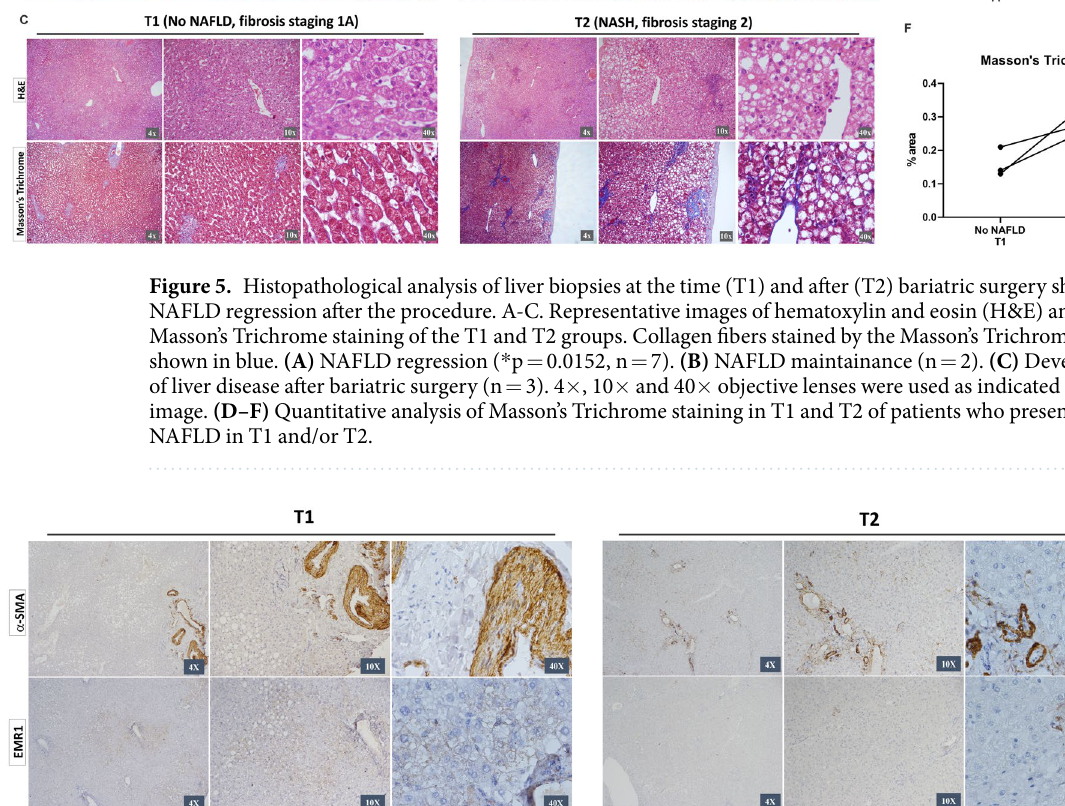
affection worldwide in the recent decades. On the other hand, liver disease associated with obesity and the conse- quent evolution to steatosis, steatohepatitis, cirrhosis and hepatocellular carcinoma has become one of the main causes of liver failure and transplantation in recent years, with the aggravating possibility of recurrence in the transplanted organ 36,37 . In our cross-sectional retrospective study, the NAFLD incidence evaluated by histological examination was 46.48% among the morbidly obese patients who underwent bariatric surgery, and 50% in the first timepoint of the paired longitudinal study. This incidence in bariatric patients was verified in other studies with smaller sample sizes 38–43 . While most of the studies evaluated NAFLD after bariatric surgery by ultrasound scan or another image or laboratory methods, our group performed liver biopsy at two distinct timepoints. Some